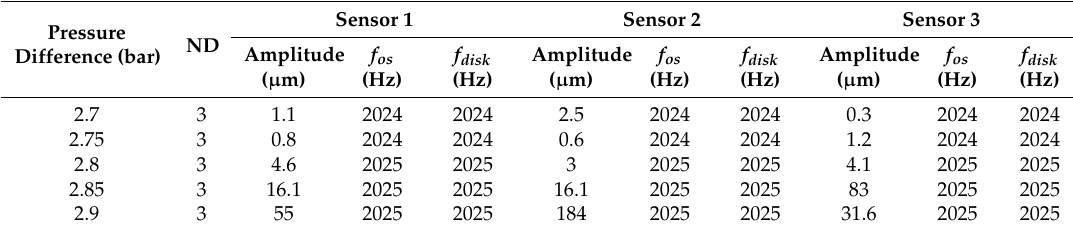
Table 6. Results for the second prototype at 0 rpm.